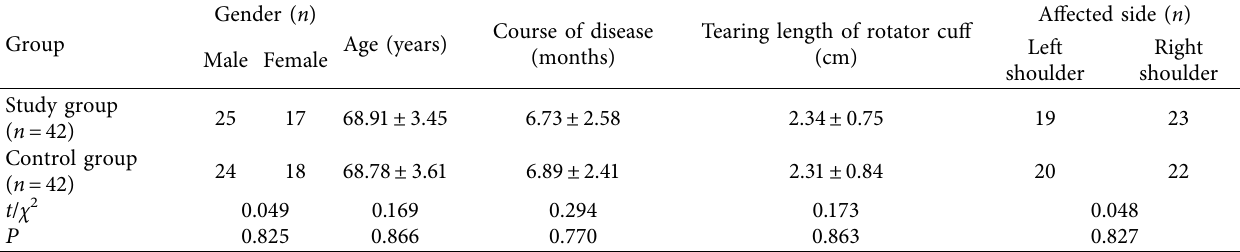
Table 1: General information.